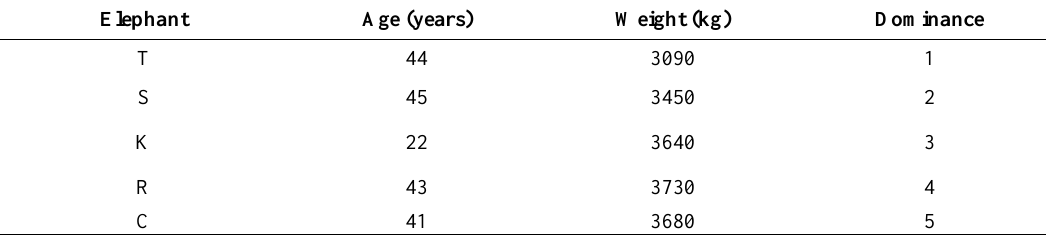
Age, Weight, and Dominance Rank of Elephants at Time of Study Elephant Age (years)